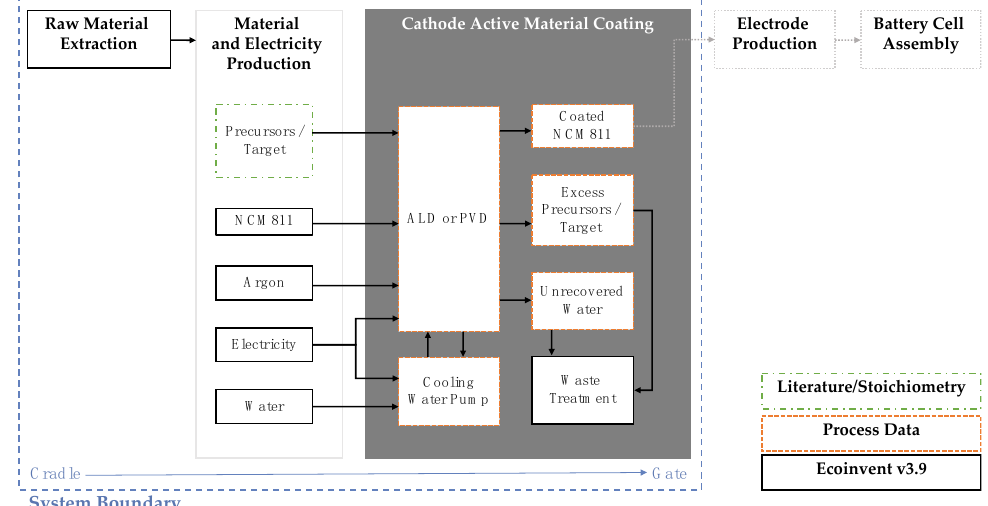
Figure 5. System Boundary (cradle-to-gate) for the Environmental Assessment.